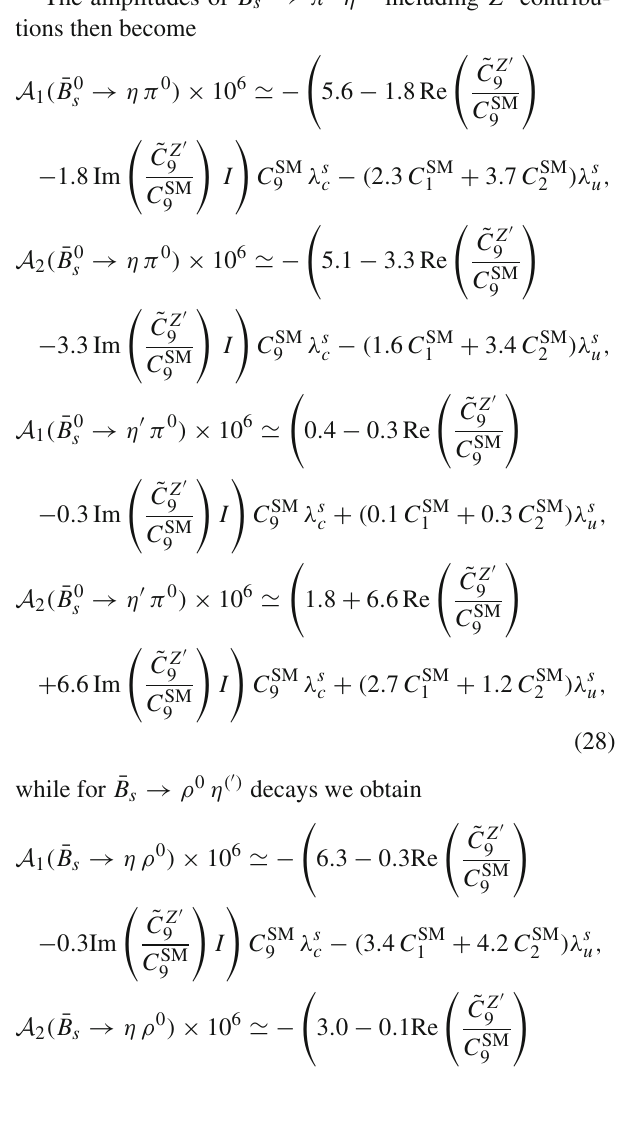
) –Im ((cid:5) bs ) plane in RHS Right allowed regions in the Im ((cid:5) bs R R ( S ψφ ). bounds on (cid:5) M B s ) –Re ((cid:5) bs ) plane in LRS from the In all plots we take M Z (cid:3) = 1TeV R L ) = Im ((cid:5) bs ) = 0. L R